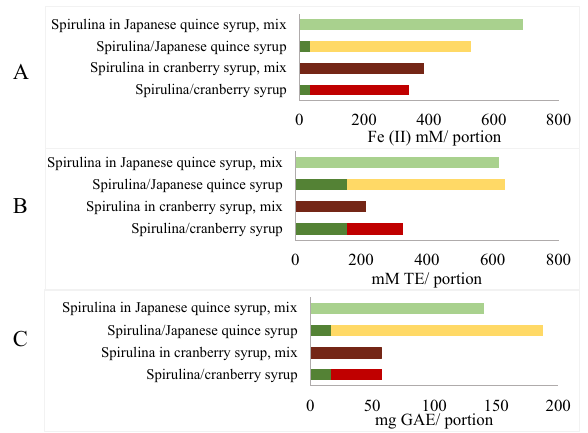
Figure 4. Reducing power ( A ), antioxidant activity ( B ) and polyphenol content ( C ) per portions of product (7 g fresh spirulina, 14 g Japanese quince, and cranberry syrups, and a mixture of spirulina and